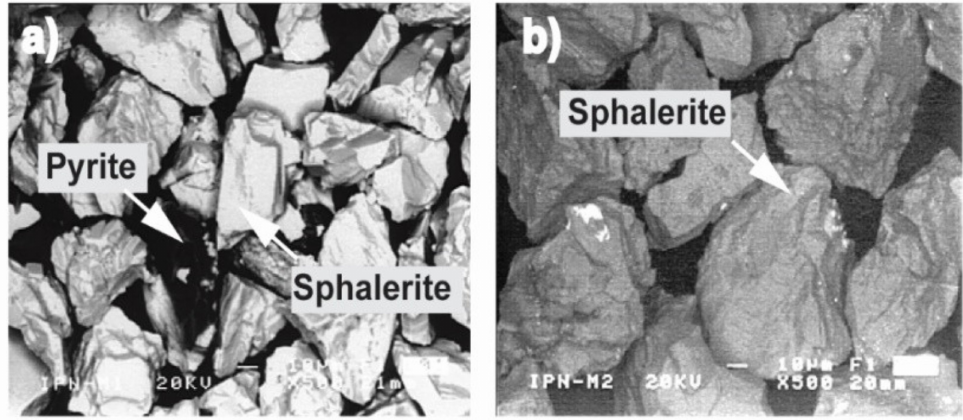
Figure 13. Surface morphology of sphalerite particles ( a ) before electrolysis; ( b ) after electrolysis.